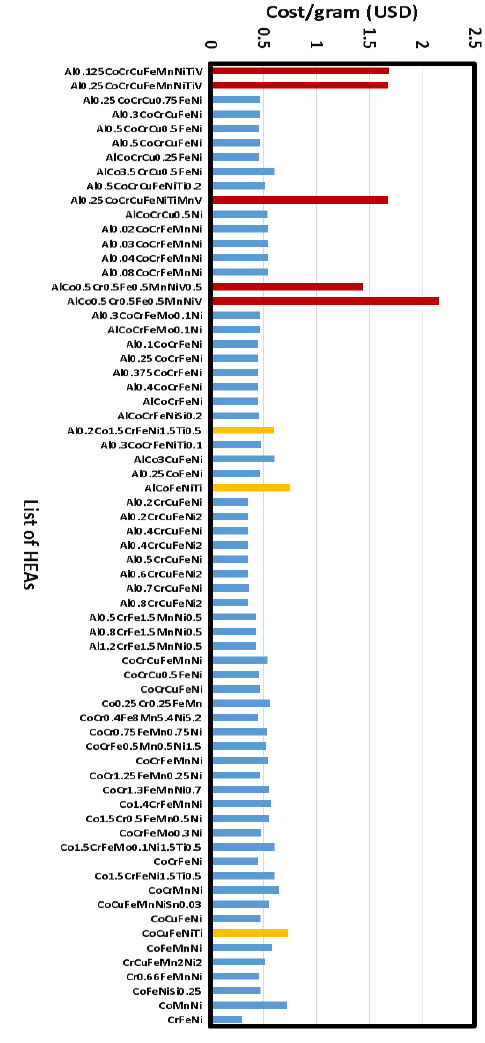
Figure A1. Estimated cost/gram of different HEAs to be used for additive manufacturing. Red color bars indicate very expensive HEAs whereas yellow bars indicate alloys with Ti.